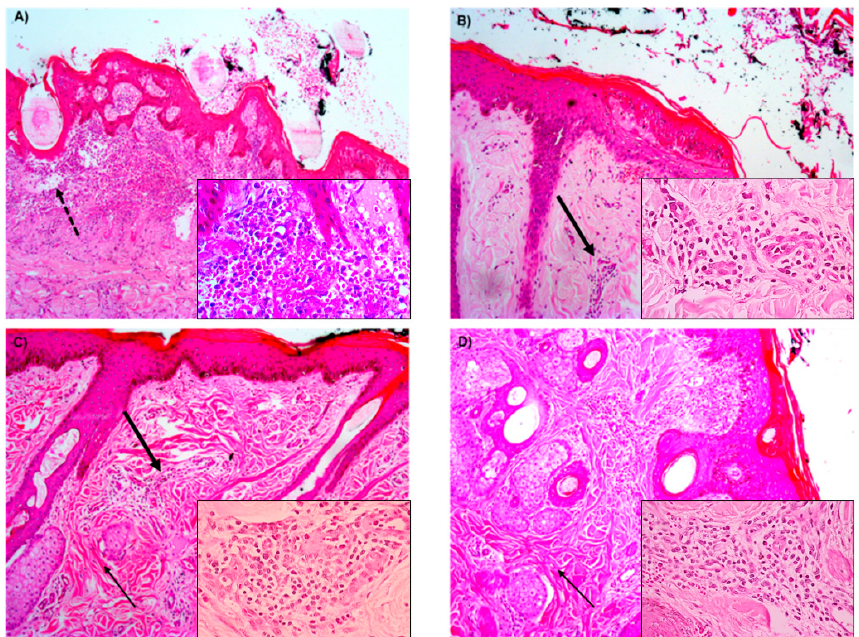
Figure 5. Photomicrographs of the slides at the different times of the skin biopsies stained by hema- toxylin and eosin at 100× and 400× (insets) magnification; ( A ) animal in the control group at 7 days, with active inflammation, characterized by marked inflammatory infiltrate (inset); ( B ) animal in the membrane group, 7 days, with chronic inflammation, noting the beginning of tissue reorganization and decrease of inflammatory cells with mononuclear pattern (inset); ( C ) animal in the membrane group, 14 days, with chronic-active inflammation (inset), with areas of fibrosis and edema; ( D ) ani- mal in the membrane+nisin group, 21 days, with chronic-active inflammation (inset), greater tissue reorganization, areas of fibrosis, and cellular accumulation of restructuring. Note: the dotted arrow indicates area of edema; thick arrow indicates area of inflammatory infiltrate; thin arrow indicates area of fibrosis.